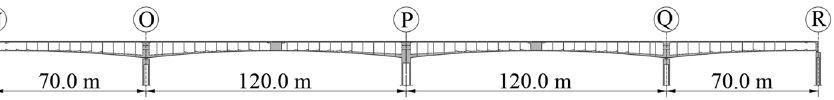
Fig. 2 Elevation of El-Warrak Bridge over the Nile River